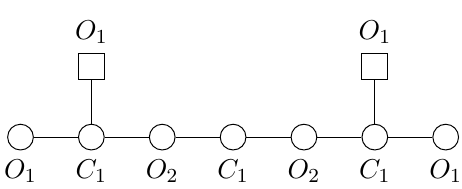
Figure 68. Quiver obtained from brane systems in the second row of table 6. Its Higgs branch is M H = D 5 .